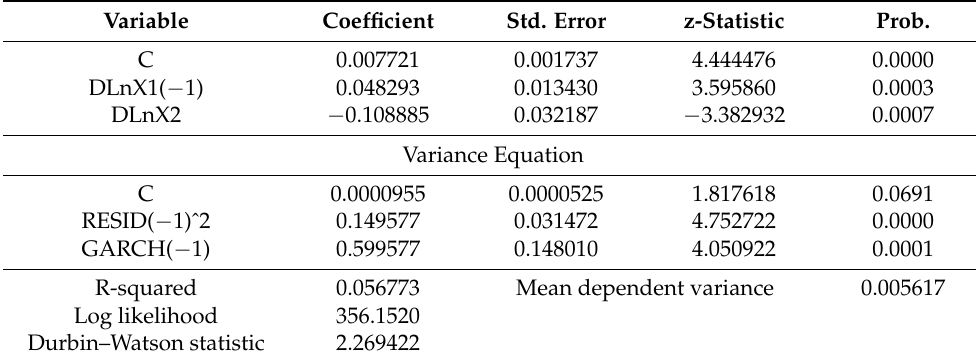
Dependent variable: DLnY. Method: ML ARCH—normal distribution (OPG— BHHH/Marquardt steps). Sample (adjusted): 2007M07 2020M04. Included observations: 154 after adjustments. Convergence not achieved after 500 iterations. Coefficient covariance computed using outer product of gradients. Presample variance: backcast (parameter = 0.7). GARCH = C(4)